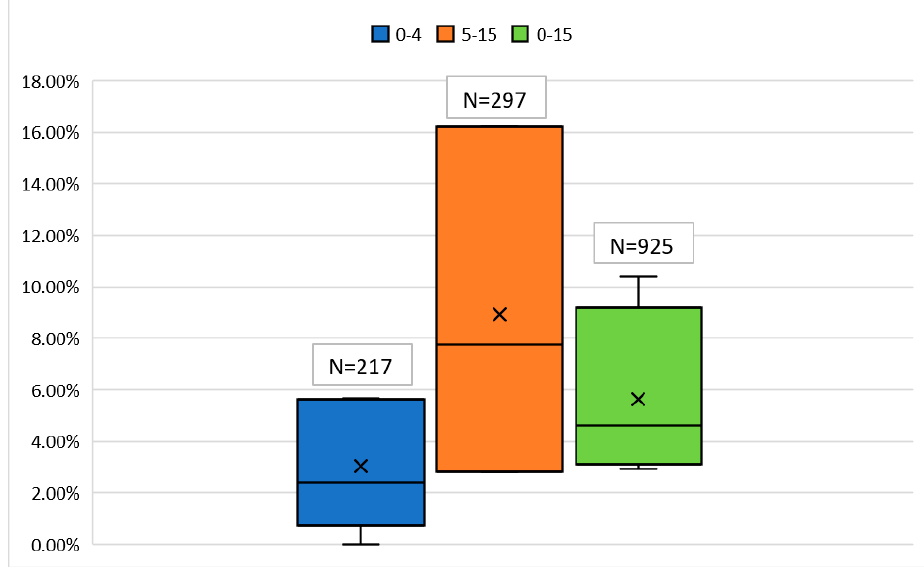
Figure 6. Comparative prevalence of HBsAg among under-15 Bangladeshi children of different age groups.